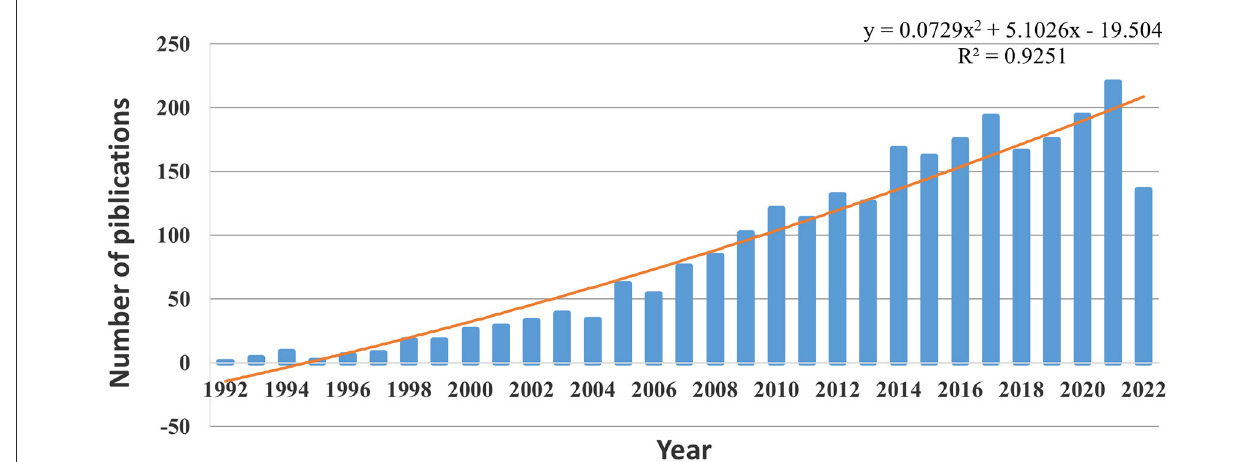
FIGURE2 Trends in the number of publications on ADHD neuroimaging from 1992 to 2022.